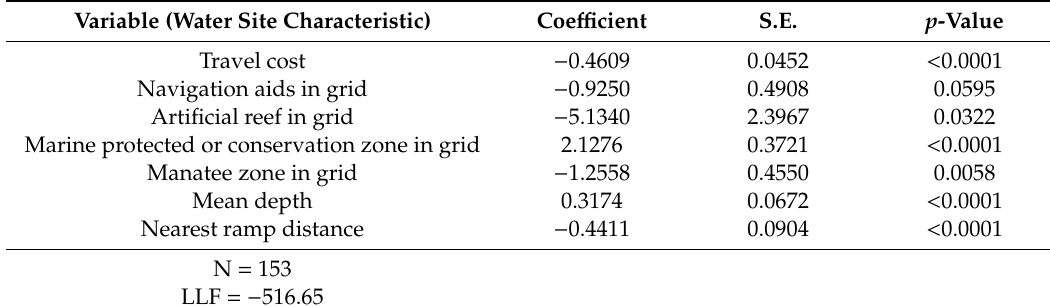
Table 1. Random utility model estimates for choice of water